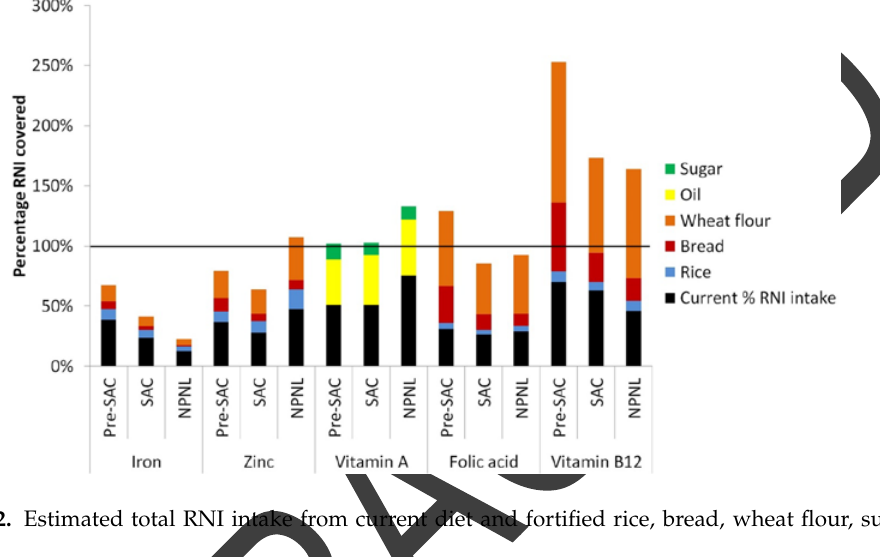
Figure 2. Estimated total RNI intake from current diet and fortified rice, bread, wheat flour, sugar, and oil.